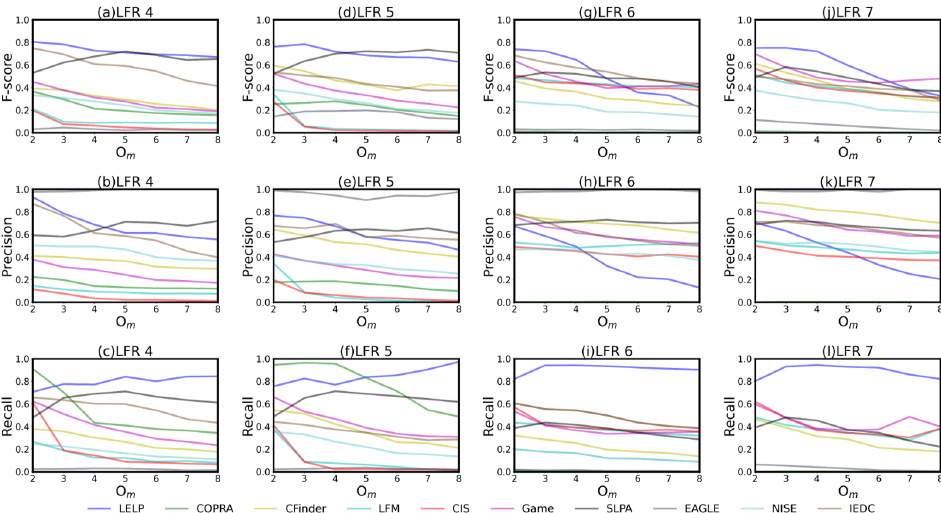
Figure 5. Sub figure ( a , d , g , j ) represent the F-score of algorithms in LFR 4 to LFR 7. Sub figure ( b , e , h , k ) represent the precision of algorithms in LFR 4 to LFR 7. Sub figure ( c , f , i , l ) represent the recall of algorithms in LFR 4 to LFR 7. In LFR 4 to LFR 7, there are different overlapping nodes O n and community sizes but other conditions are the same.